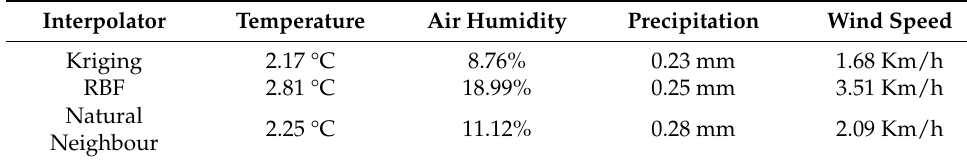
Table 2. Averaged MAE of the interpolation